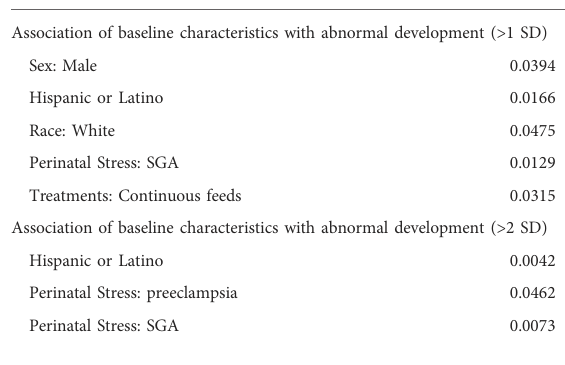
TABLE 5 Association of baseline characteristics with abnormal development ( n